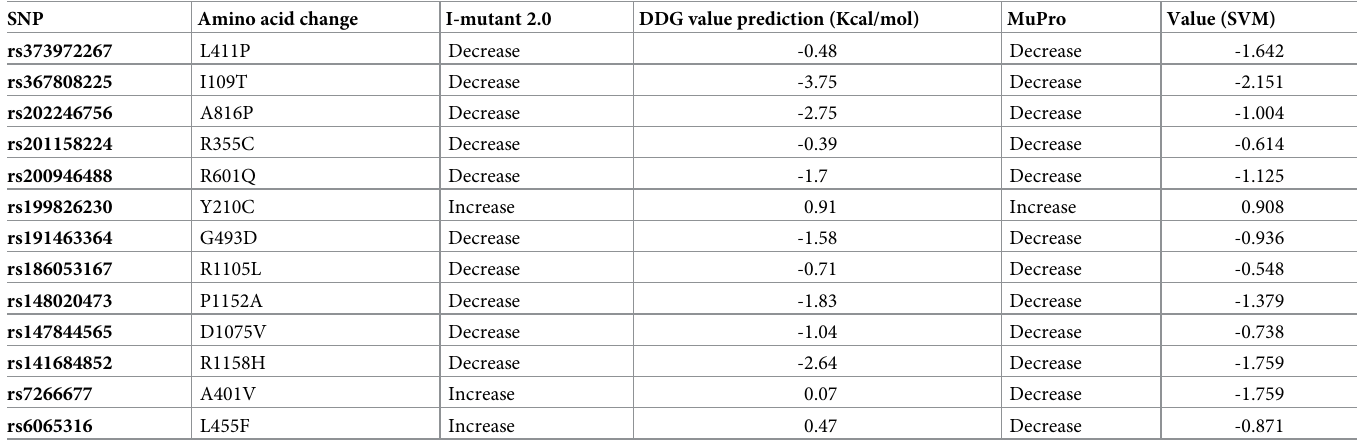
Table 3. Prediction of protein stability of nsSNPs by I-mutant 2.0 & MuPro. SNP Amino acid